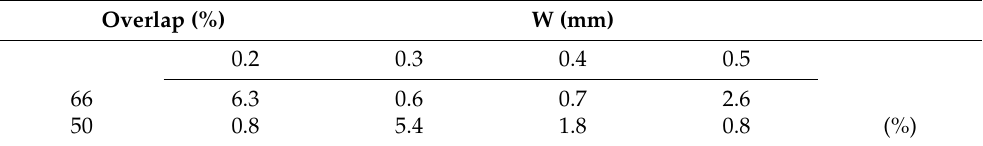
Table 3. Surface topography